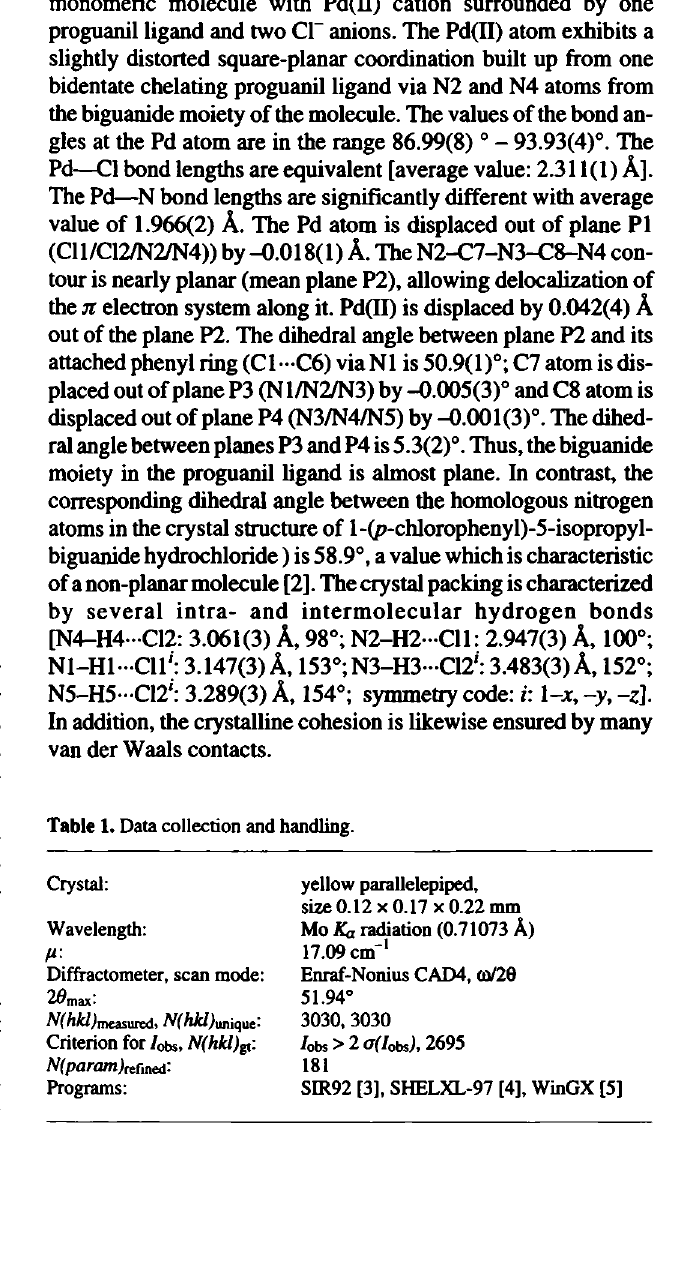
Table 1. Data collection and handling.